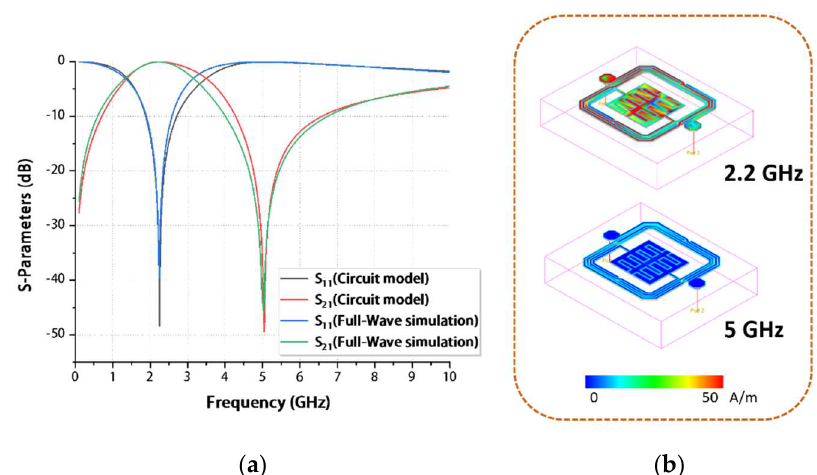
Figure 4. ( a ) S 11 and S 21 of the circuit model and full-wave simulations. ( b ) Current density at 2.2 and 5 GHz.